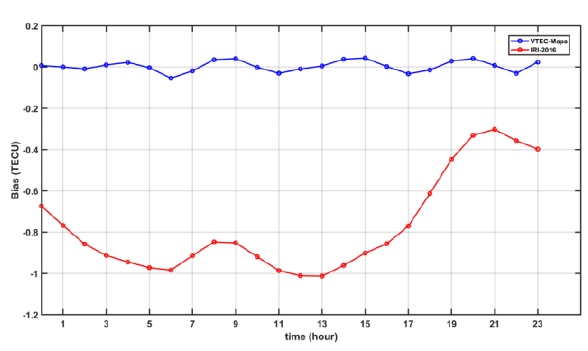
Figure 7 . The time series of bias